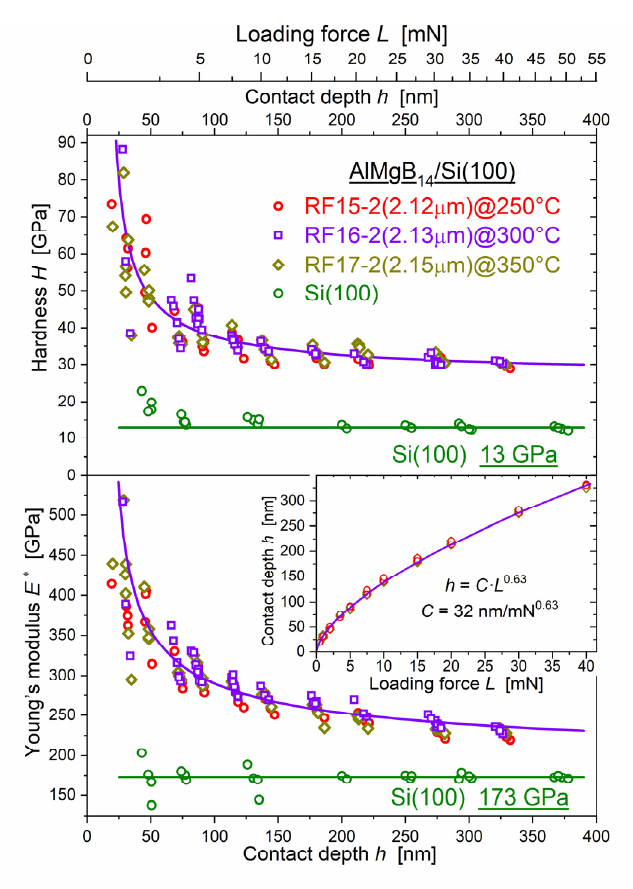
Figure 5. Hardness H and elastic Young’s modulus E ∗ dependencies upon contact depth h and loading force L measured in three di ff erent AlMgB 14 films fabricated within the “favorable” temperature range 250–350 ◦ C. Hardness H = 13 GPa and modulus E ∗ = 173 GPa for a blank single crystal Si(100) wafer are shown for comparison. In inset, solid line is a power law h = C · L 0.63 with C = 32 nm / mN 0.63 fits experimental data for contact depth vs. loading force dependence.